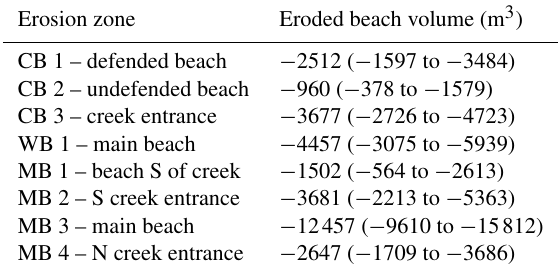
Table 5. Beach erosion volumes for erosion zones referred to in Fig. 7. Bracketed values show volume range within reported accu- racy of lidar ( ± 0 . 15m to 1 RMSE, or 68% confidence).